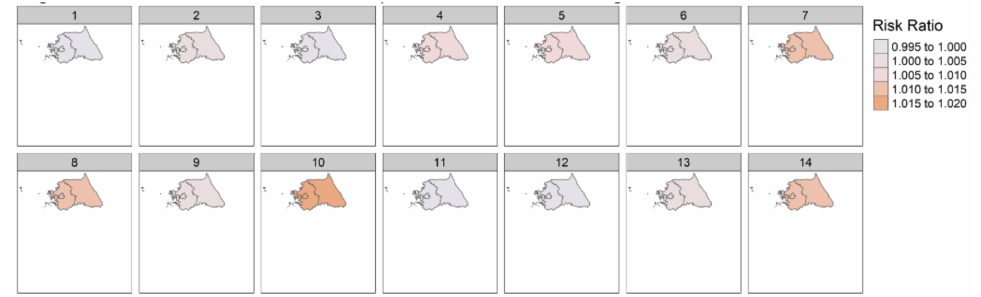
Figure 2. Association between DTR and amputation of diabetic foot in region